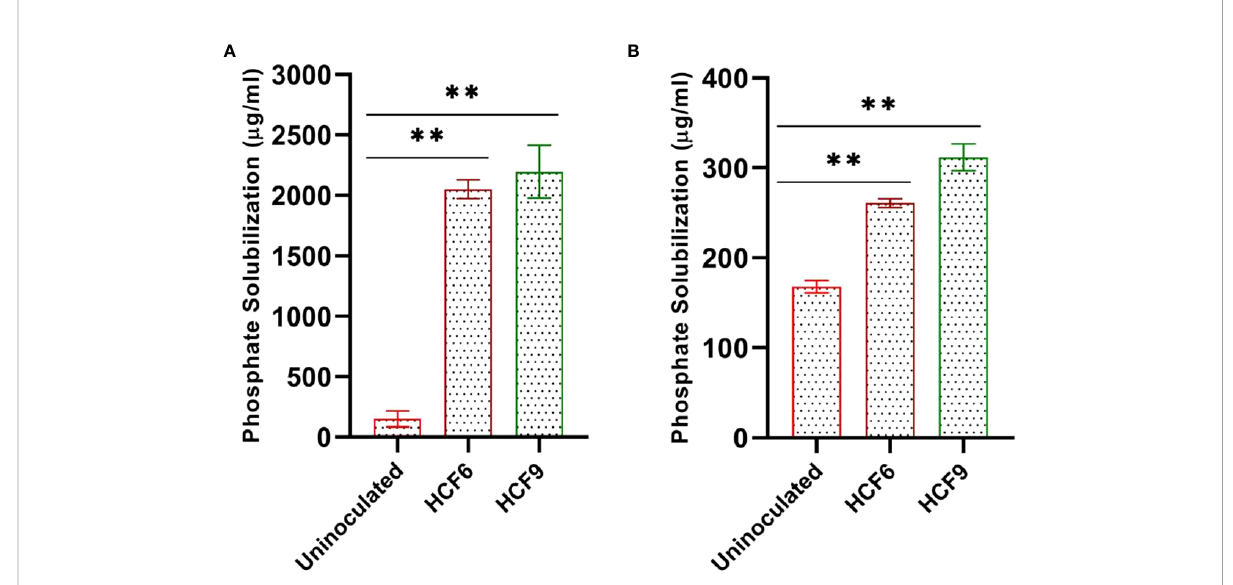
FIGURE 2 Quanti fi cation of soluble phosphate released from NBRIP liquid media after 3 days incubation. (A) Test bacteria inoculated with Ca 3 (PO 4 ) 2, and (B) with AlPO 4 showing signi fi cant difference from uninoculated media. **P <